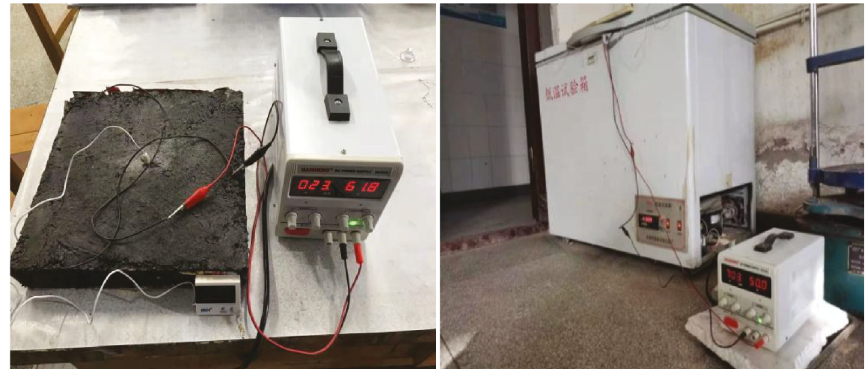
Figure 6: Simulated temperature rise test of track board in low temperature test chamber.